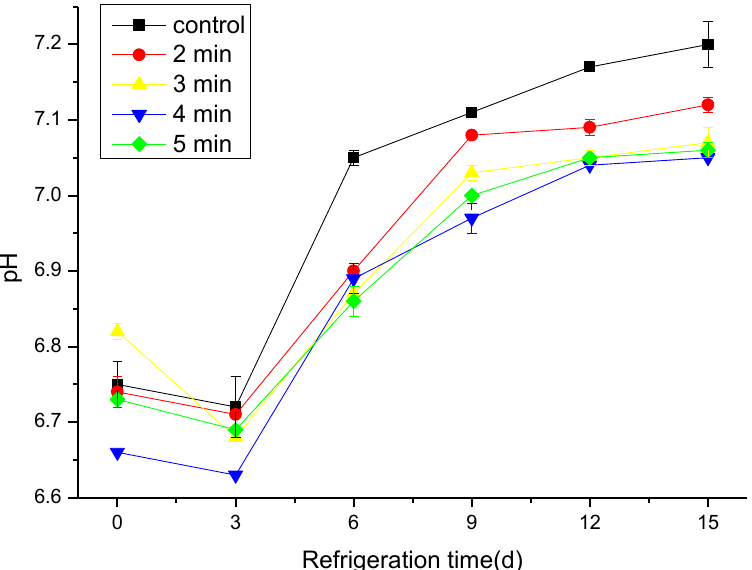
Figure 3. Changes in pH of cold stored hairtail fish exposed to CAP at 50 kV voltage for various treatment times: 2, 3, 4, and 5 min. The non-treated sample was included as a control.